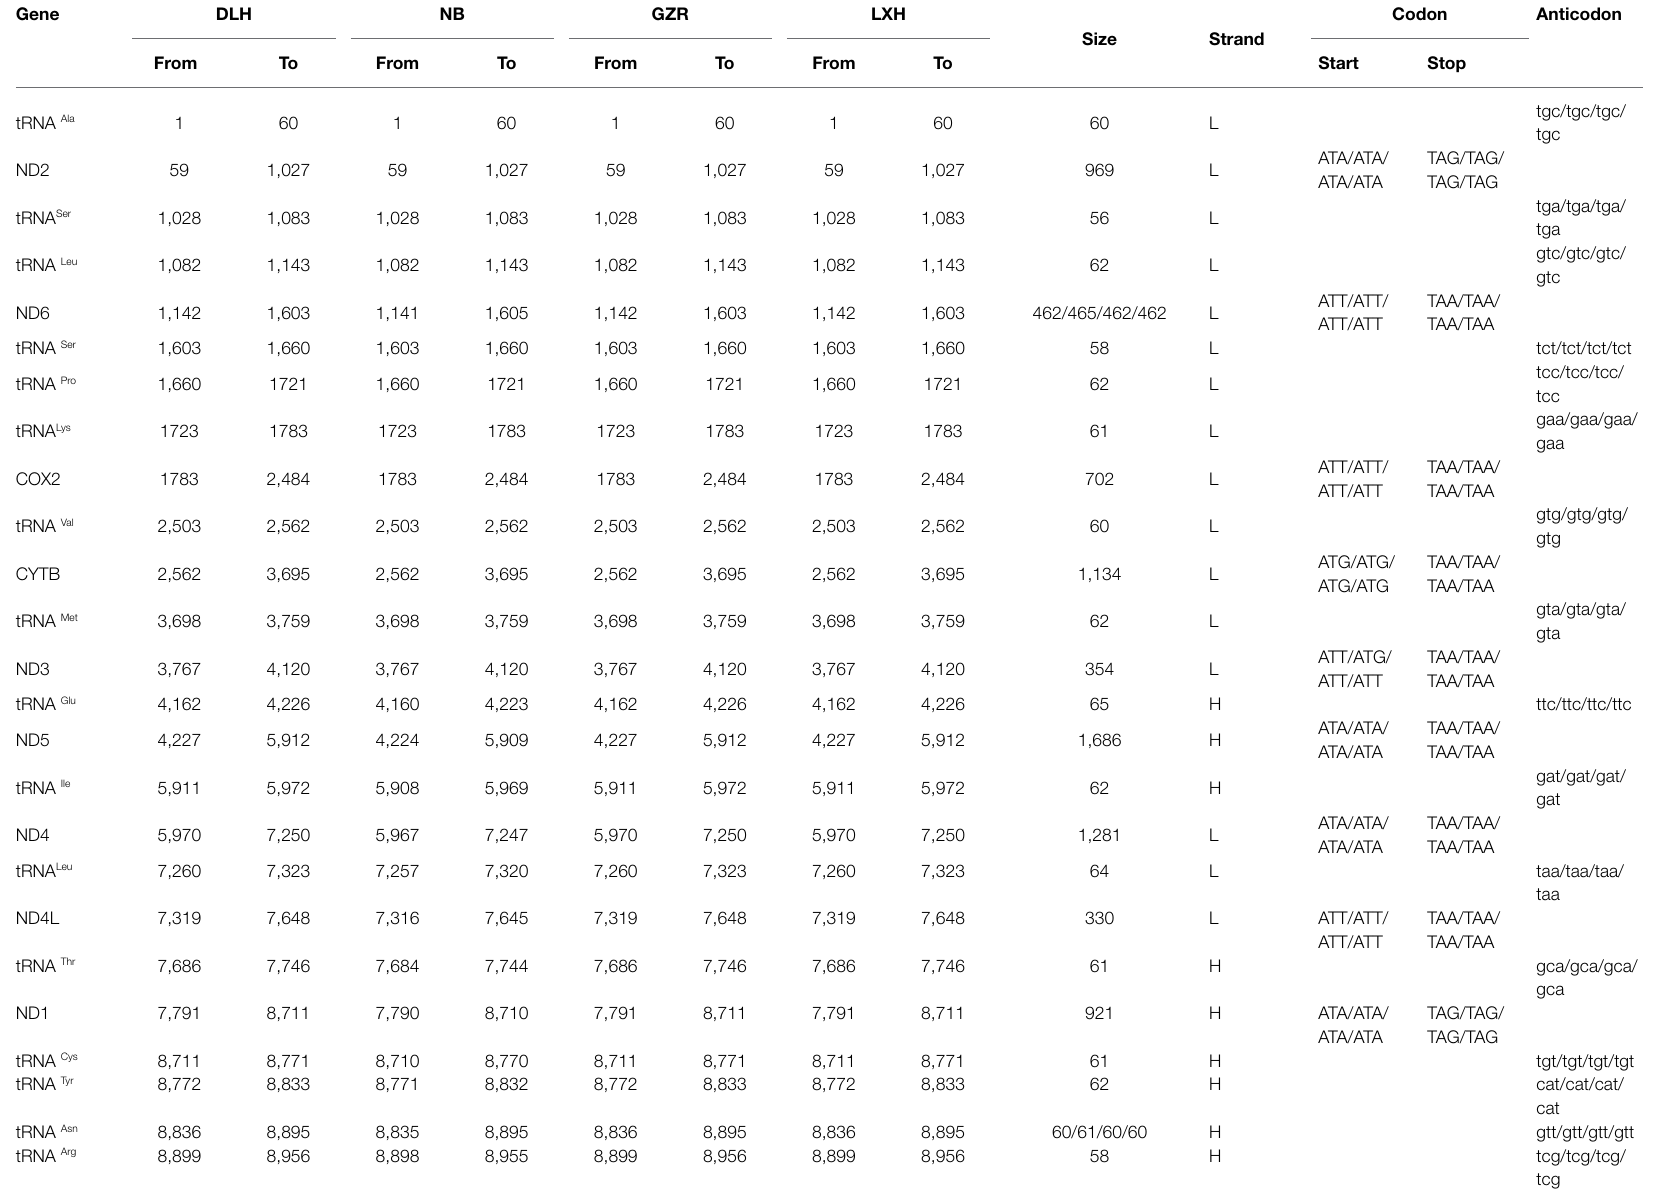
TABLE 1 | Annotation of four representative complete mitochondrial genomes of P. tunguidus .